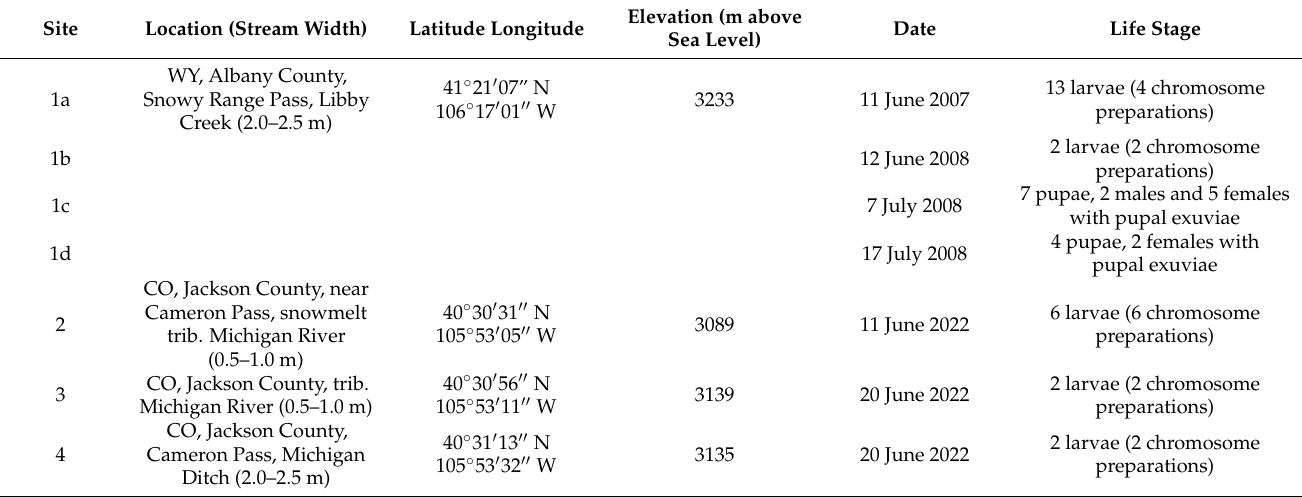
Table 1. Sites from which type material was collected for Prosimulium supernum n. sp. in the Rocky Mountains of Colorado and